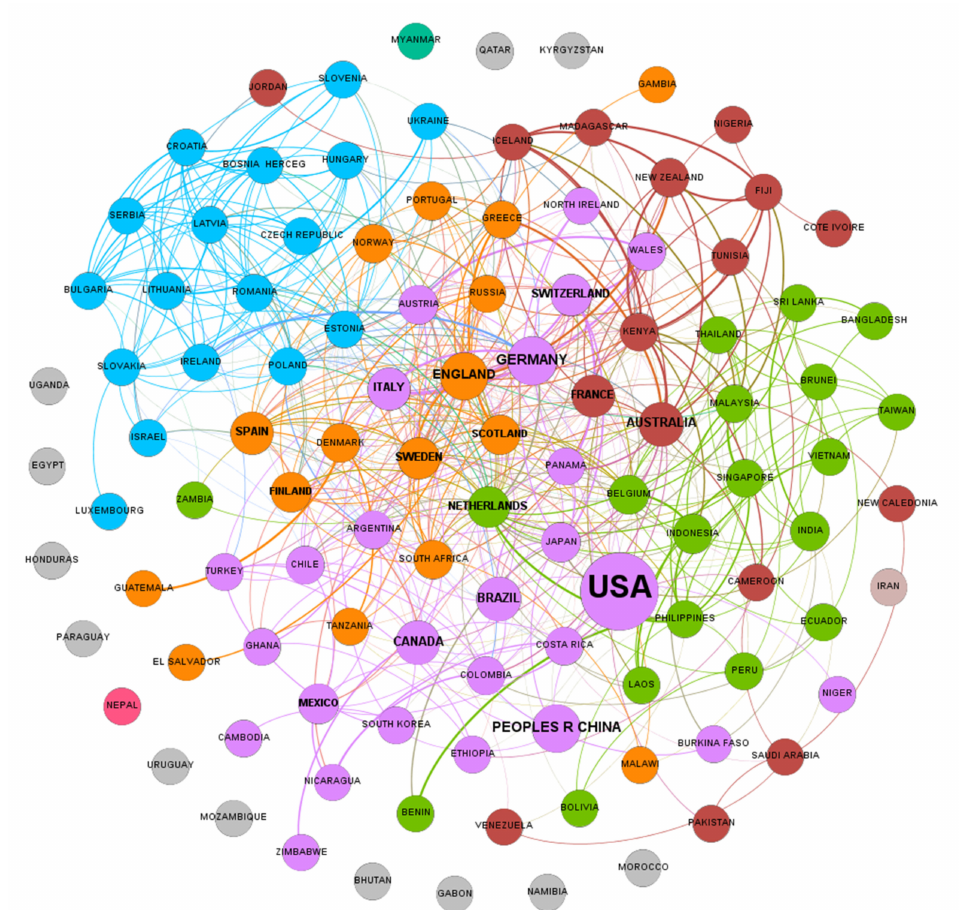
Figure 2. Institutional cooperation in research and publications on FES-related topics among countries. The size of each country (node) in the network is directly proportional to its number of occurrences in the documents analyzed. Colors indicate the clusters to which country is unequivocally assigned on the basis of their reciprocal relatedness (gray represents